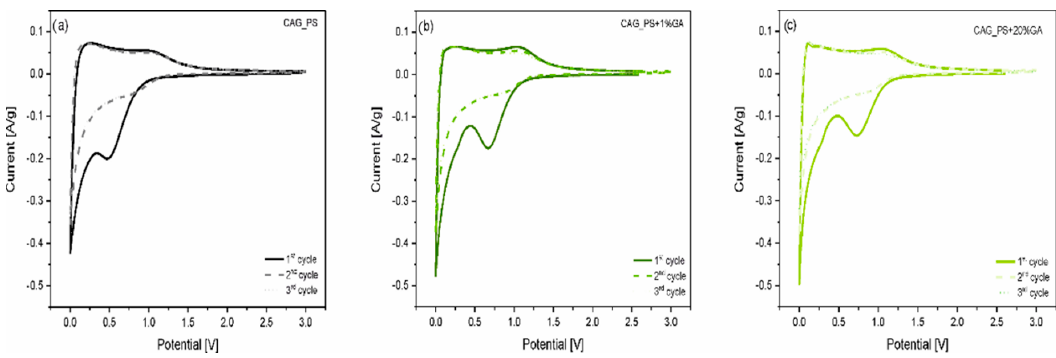
Figure 4. Cyclic voltammetry (CV) curves of ( a ) CAG_PS ( b ) CAG_PS+1%GA and ( c ) CAG_PS+20%GA-based half cells at a scan rate of 0.1 mV/s in the voltage range of 0.001–3 V.